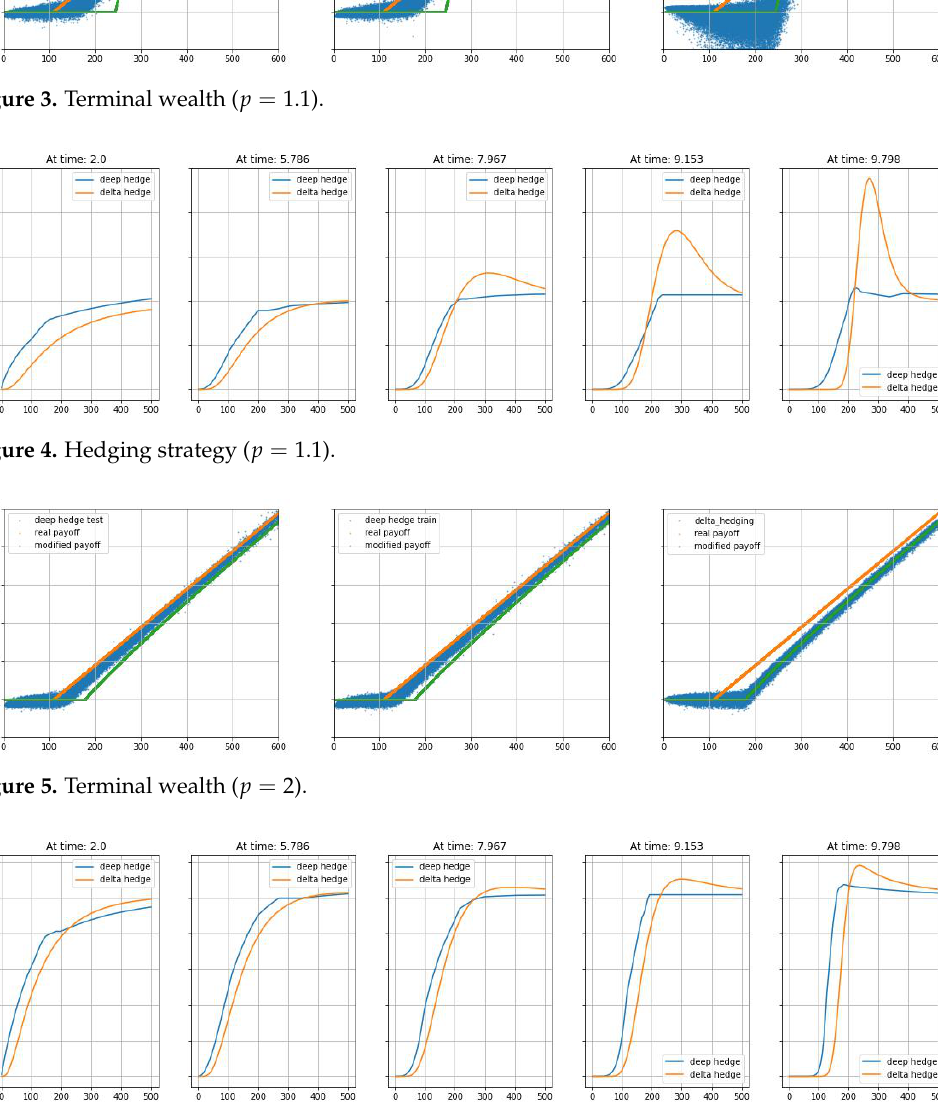
Figure 6. Hedging strategy ( p =